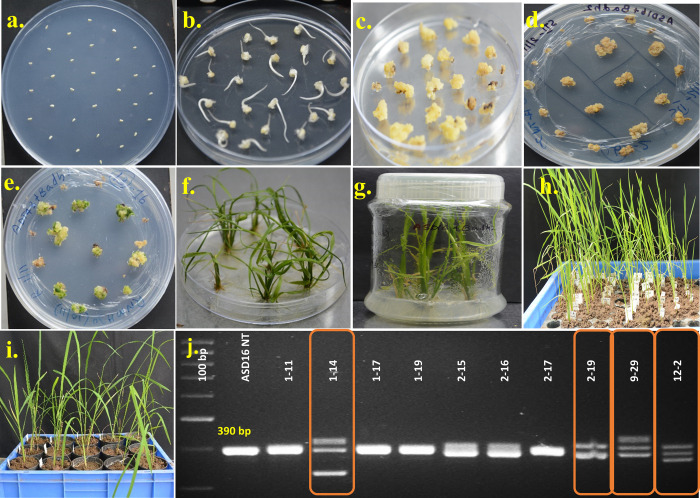
Agrobacterium-mediated transformation of immature embryos of rice cultivar ASD16 with pRGEB31 vector harbouring BADH2-sgRNA.a) Co-cultivated immature embryos; b) Immature embryo derived calli (7 days after co-cultivation); c) Resting stage; d) Selection using hygromycin; e) Regeneration of putative transformants; f) Shooting and root initiation; g) Second rooting; h) Hardening of putative transgenic plants in portrays; i) Establishment of putative transgenic plants under transgenic greenhouse conditions; j) Agarose gel electrophoresis showing presence of varying sizes of amplicons in the target region; the bars denotes the multi-allelic mutations.